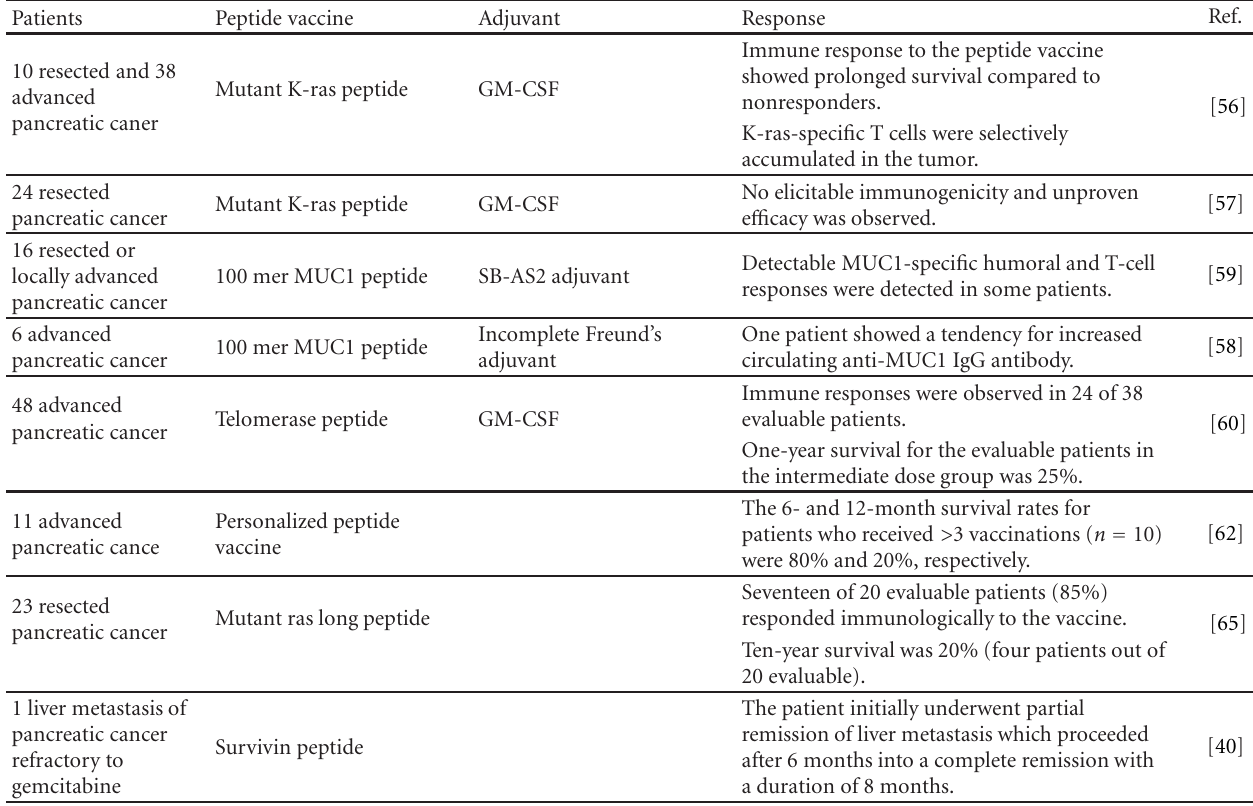
Table 1: Peptide